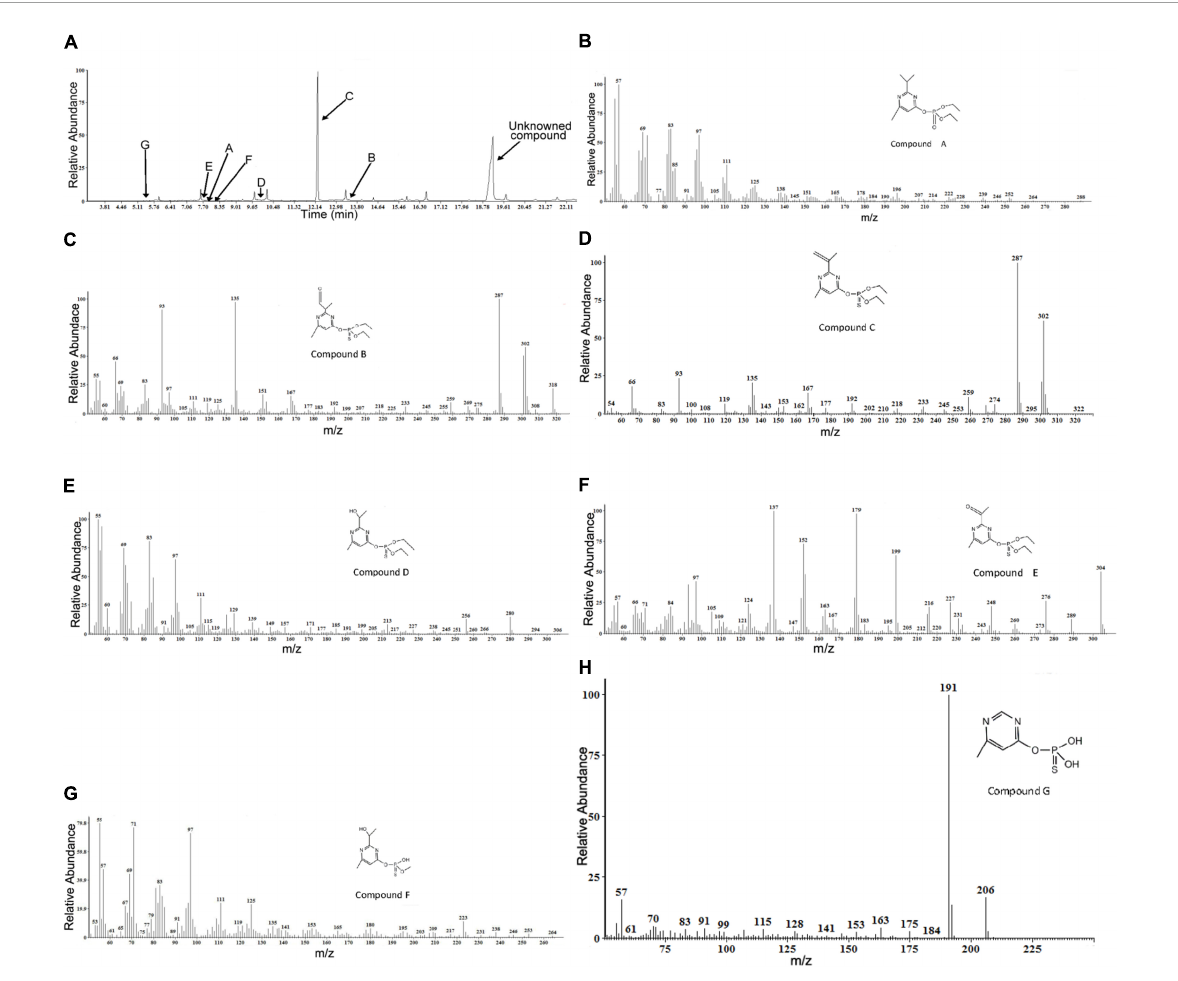
FIGURE5 Gas chromatography/mass spectrometry (GC–MS) analysis of the diazinon intermediates transformed by Sphingobium sp. DI-6: (A) Gas chromatography profiles for main intermediates (A–G) . The retention times of the compounds were 7.901, 13.489, 12.246, 9.961, 7.849, 8.301, and 5.468, respectively. (B–H) The characteristic ions of compounds (A–G) in GC–MS. They were identified as diazoxon, diazinon aldehyde, isopropenyl derivative of diazinon, hydroxyethyl derivative of diazinon, diazinon methyl ketone, O -[2-(1-hydroxyethyl)-6-methyl pyrimidin-4-yl] O -methyl O -hydrogen phosphorothioate, and O -(6-methyl pyrimidin-4-yl) O , O -dihydrogen phosphorothioate, respectively.